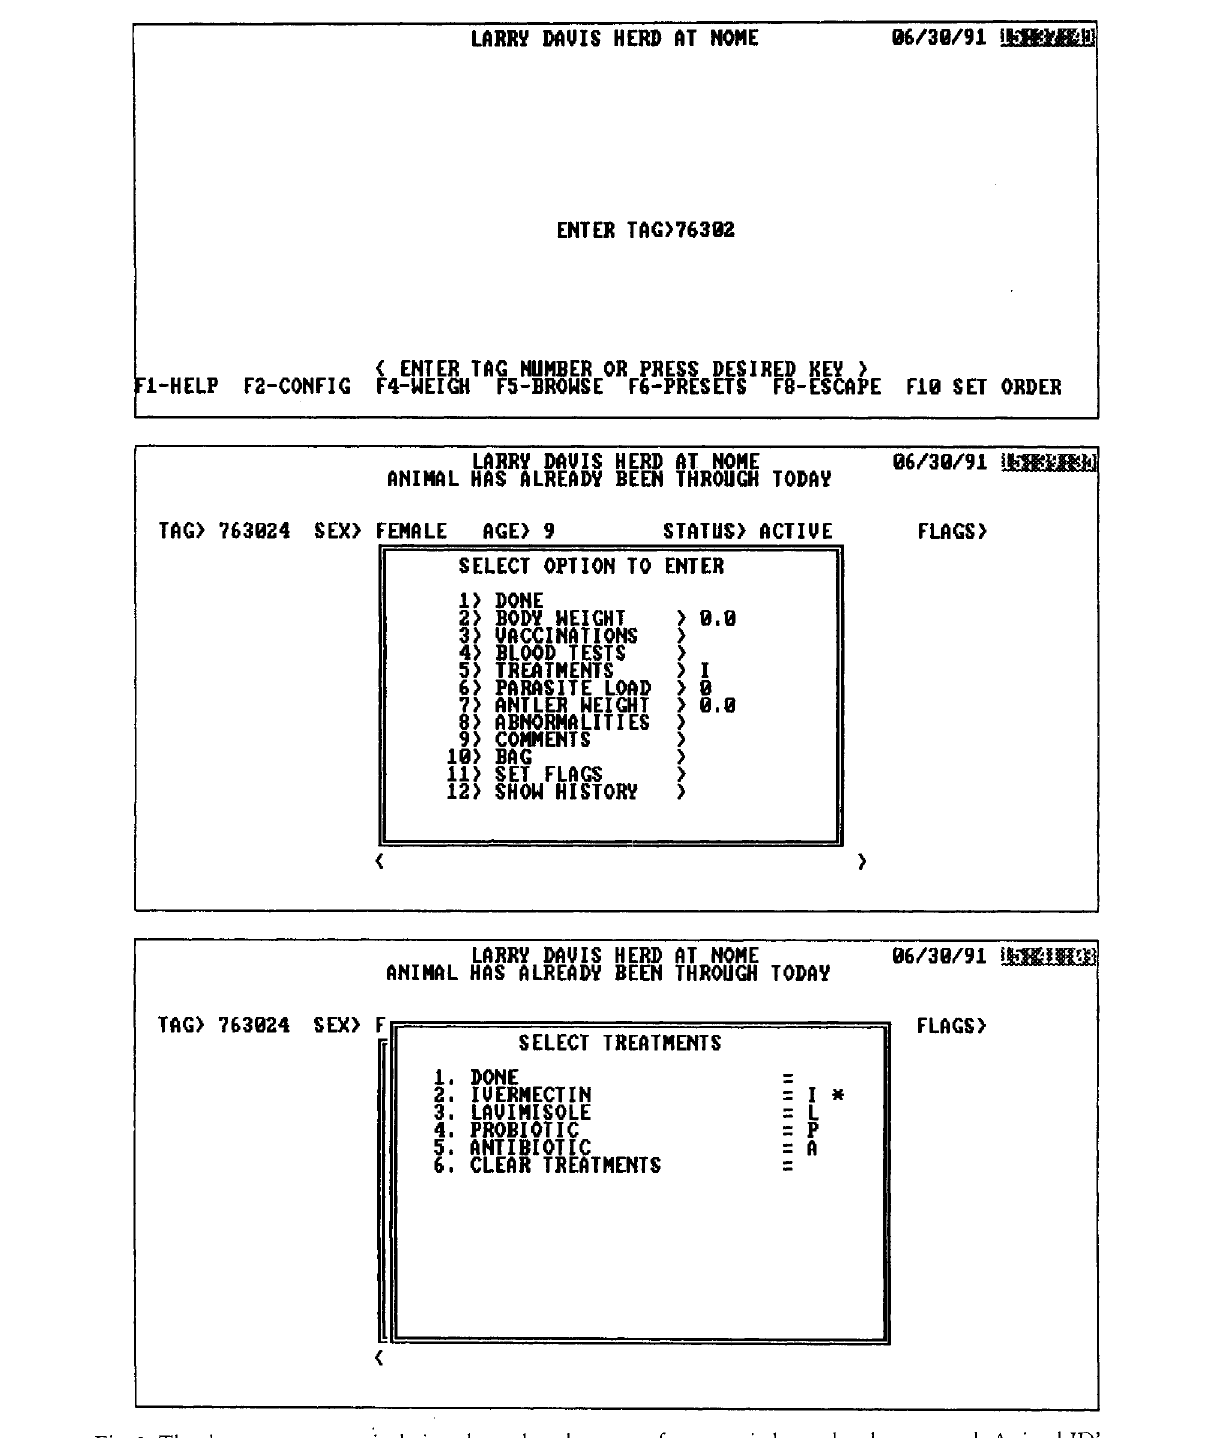
Fig. 3. The data entry system is designed to take advantage of a numeric keypad to boost speed. Animal ID's